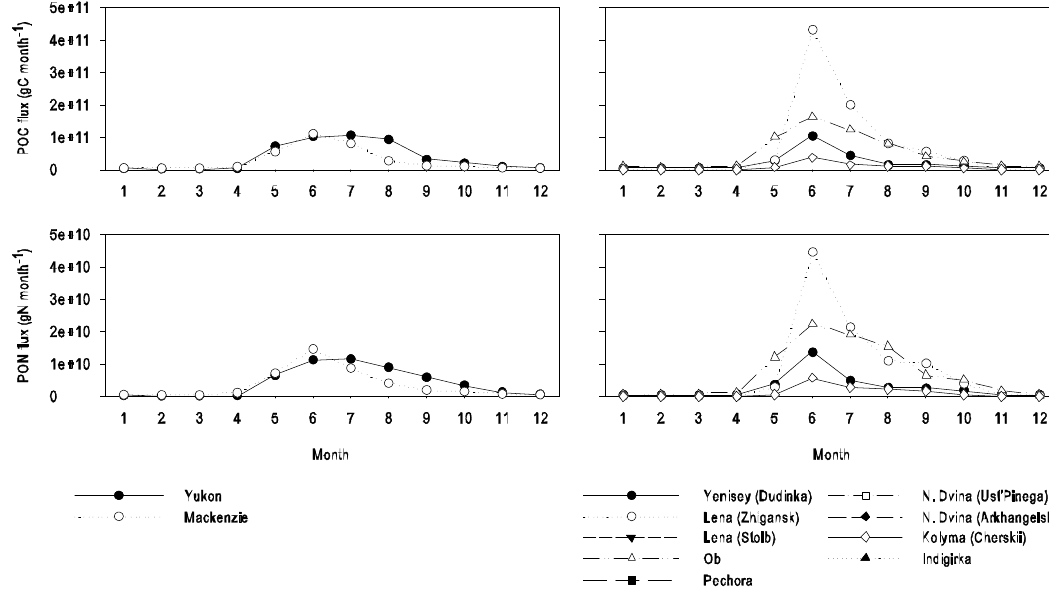
Fig. 4. Monthly flux estimates of riverine POC and PON for the North American and Eurasian rivers. (cid:0)